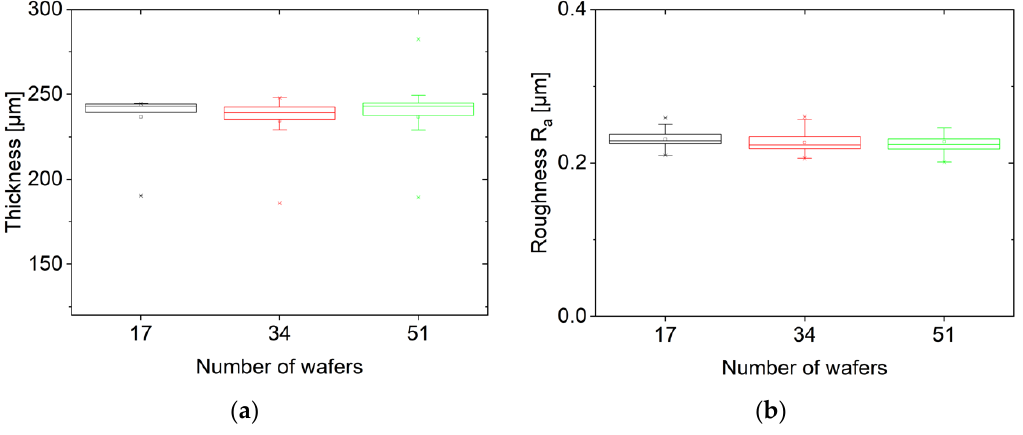
Figure 9. ( a ) Thickness variation for different numbers of wafers, ( b ) roughness values for different numbers of wafers.